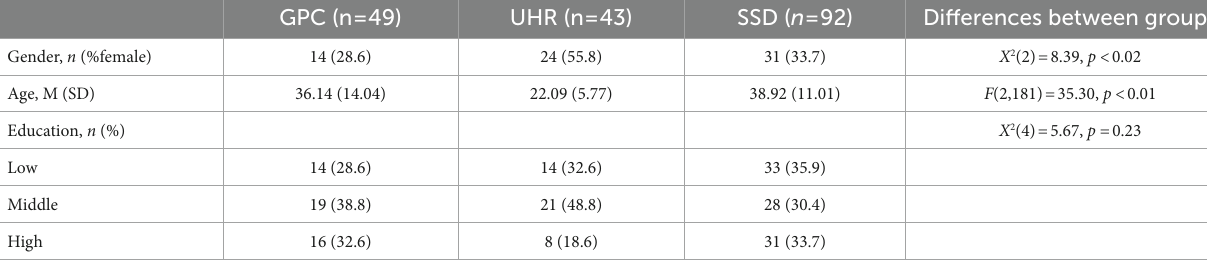
TABLE 1 Demographic information of study participants per subgroup ( N =